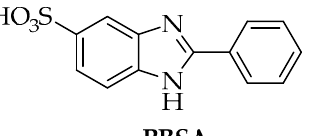
Figure 1. Lead compound.